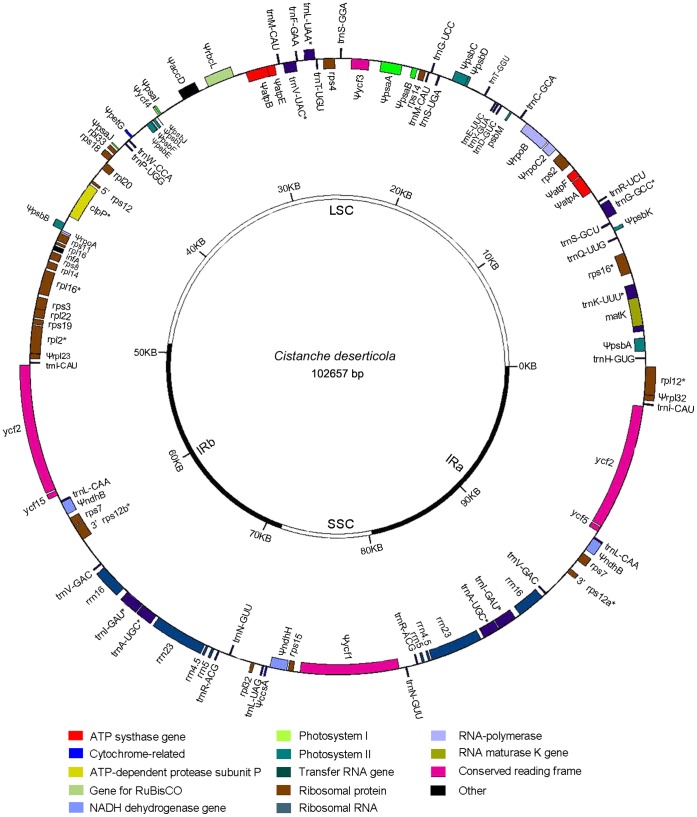
Gene Maps of the plastid chromosomes of C. deserticola.Genes shown inside the circle are transcribed clockwise, those outside the circle are transcribed counterclockwise. The large single copy region (LSC) and the small single copy region (SSC) are separated by two inverted repeats (IRa and IRb). Asterisks indicate intron containing genes. Pseudogenes are marked by Ψ.